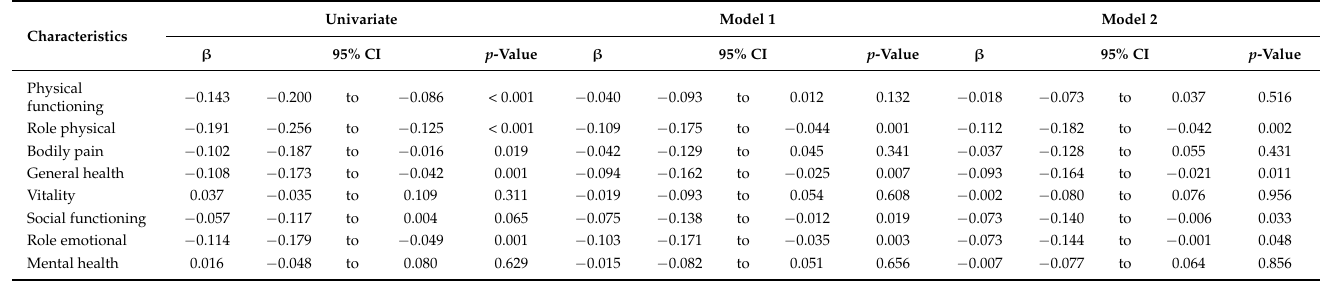
Table 6. Correlation between SF-36 scores and pentosidine levels